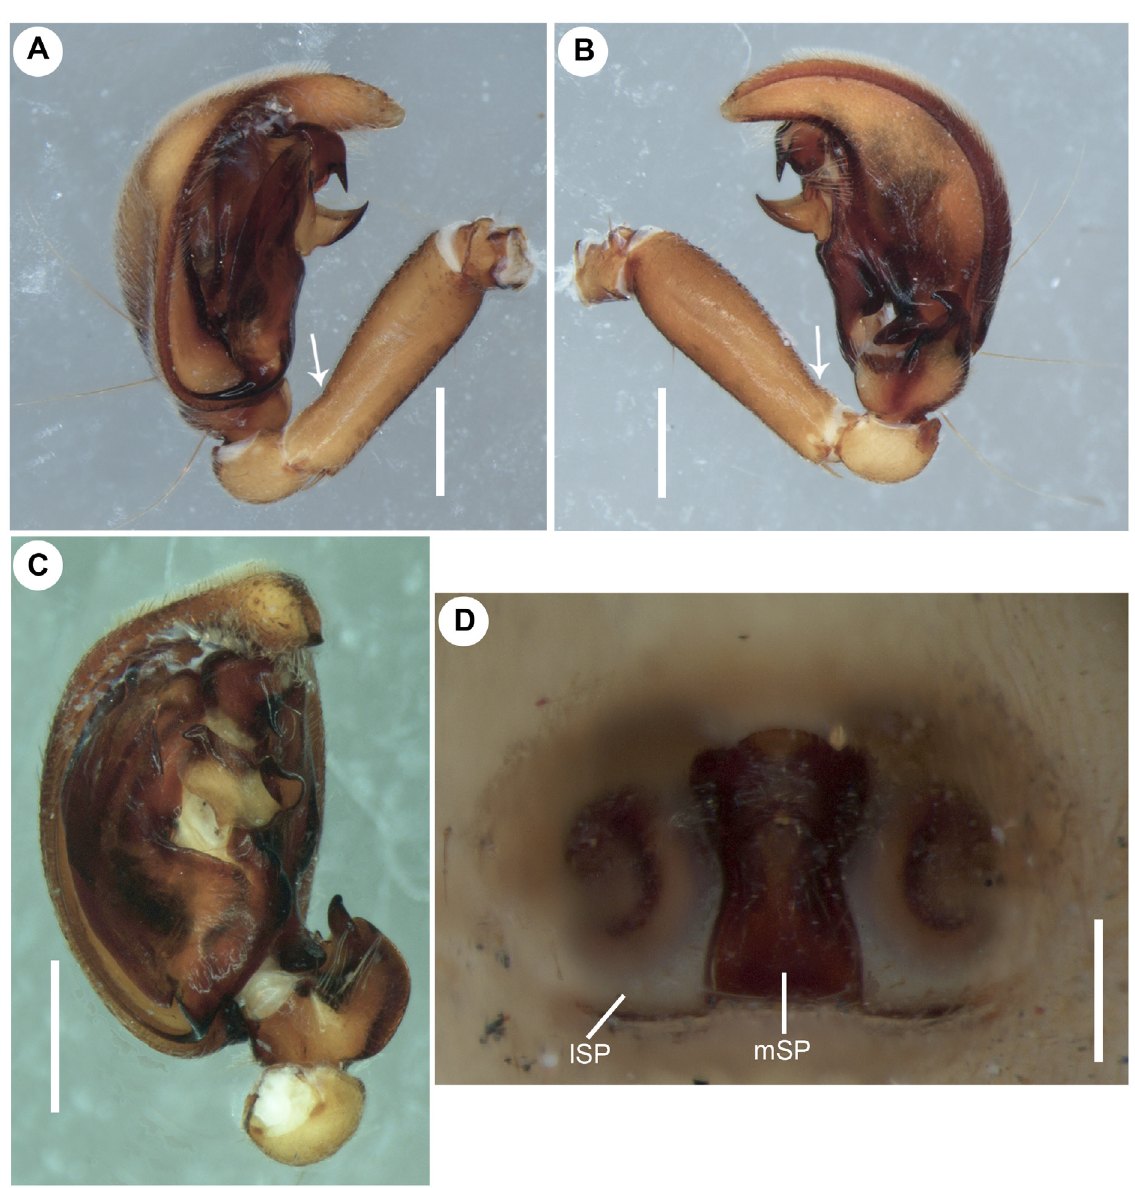
Fig. 3. Laminion birenifer (Gravely, 1921) gen. et comb. nov., ♂♀, syntypes of Storena birenifer Gravely, 1921 (NZC-ZSI-2914/H2). A . Left pedipalp of male, prolateral view. B . Same, retrolateral view. C . Same, ventral view. D . Epigynum of female, ventral view. Abbreviations: lSP = lateral sclerotised plate; mSP = median sclerotised plate. Scale bars: A–C = 0.5 mm; D = 0.2 mm. Arrows indicate the femoral disto-ventral